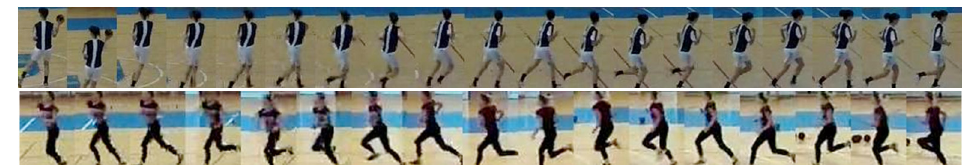
Figure 21. Tracking of players that perform actions outside of the scope.